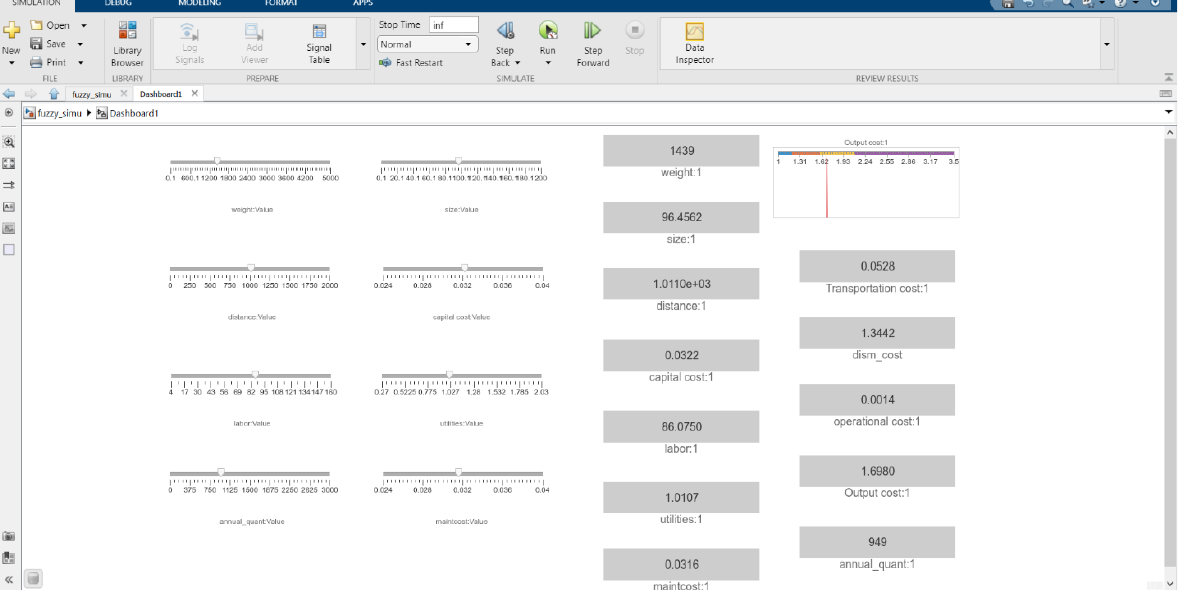
Table 7. Different case scenarios and predicted output cost for recycling CFRPs.